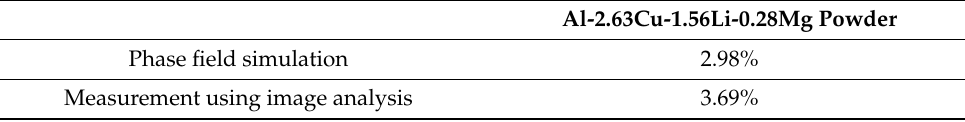
Table 5. Eutectic fraction measurement of gas ‐ atomized 20 μ m Al ‐ 2.63Cu ‐ 1.56Li ‐ 0.28Mg powder.